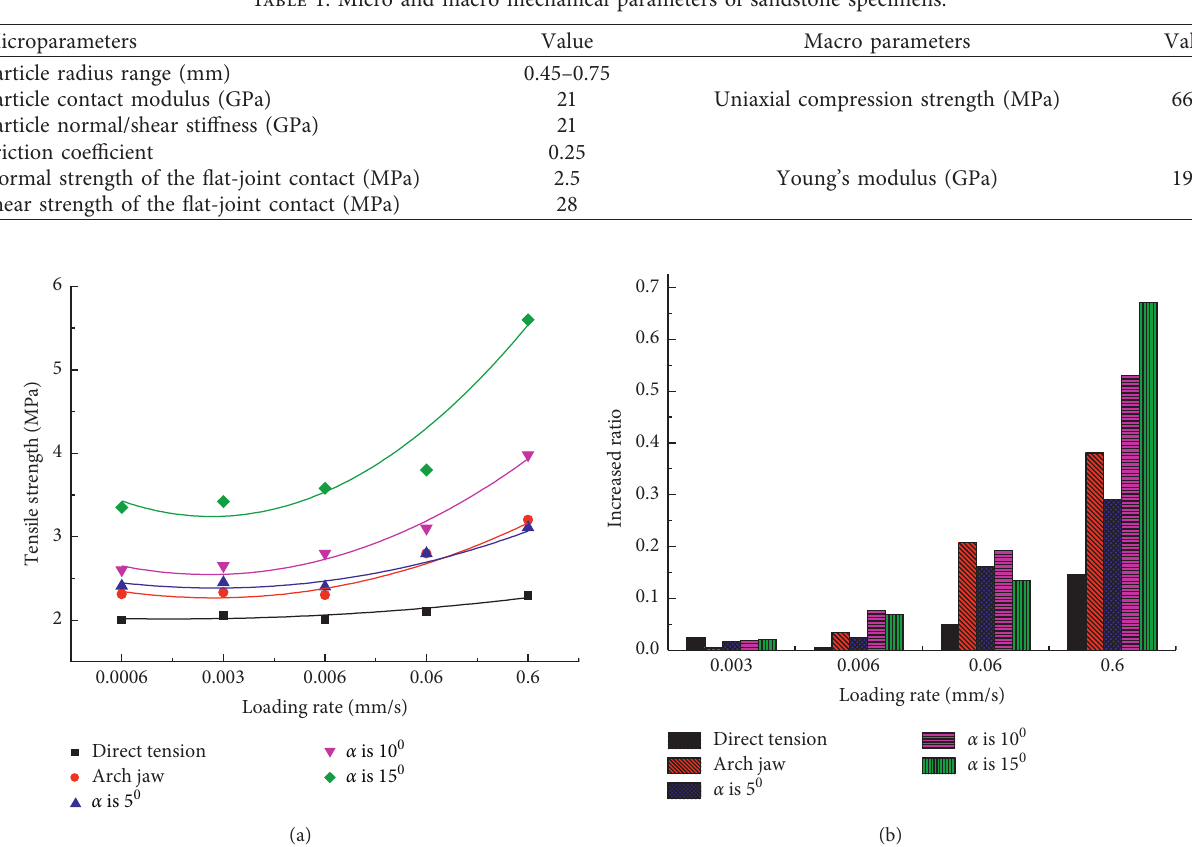
Table 1: Micro and macro mechanical parameters of sandstone specimens.